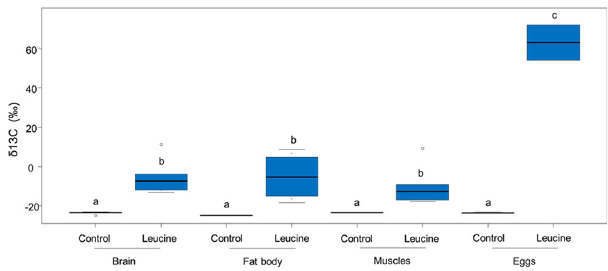
blue), and their controls (red). A higher delta indicates higher 13 C levels. The boxes represent the fi rst and third quartiles and the median. The whiskers represent the maximum and minimum values. The circles represent the outliers. A generalized linear mixed model followed by post- hoc pairwise comparisons (Tukey adjusted) was used for statistical analysis. Different letters indicate a pairwise-comparison with P <